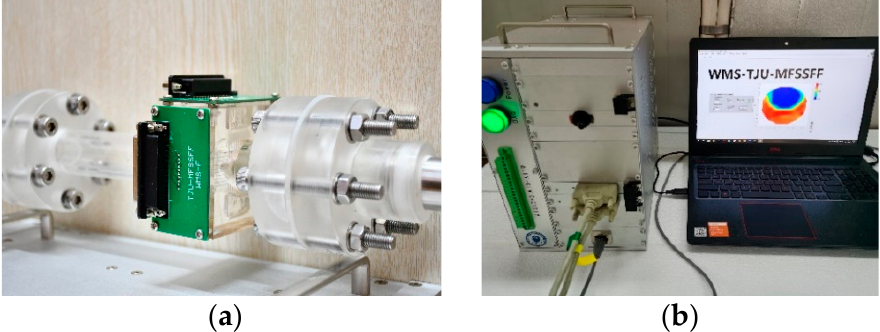
Figure 3. Wire ‐ mesh sensor system used in this study: ( a ) Wire ‐ mesh sensor; ( b ) Sensor system.